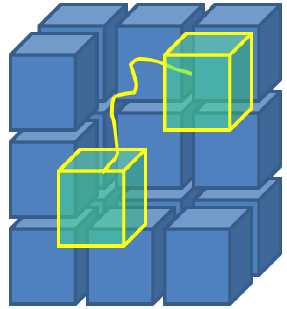
Figure 5. A scheme of the concept behind the Monte Carlo Flux method: stochastic simulations, that take place in the phase space, allow to calculate the transition frequencies q ij between sub-regions of the same phase space, obtained by arbitrary